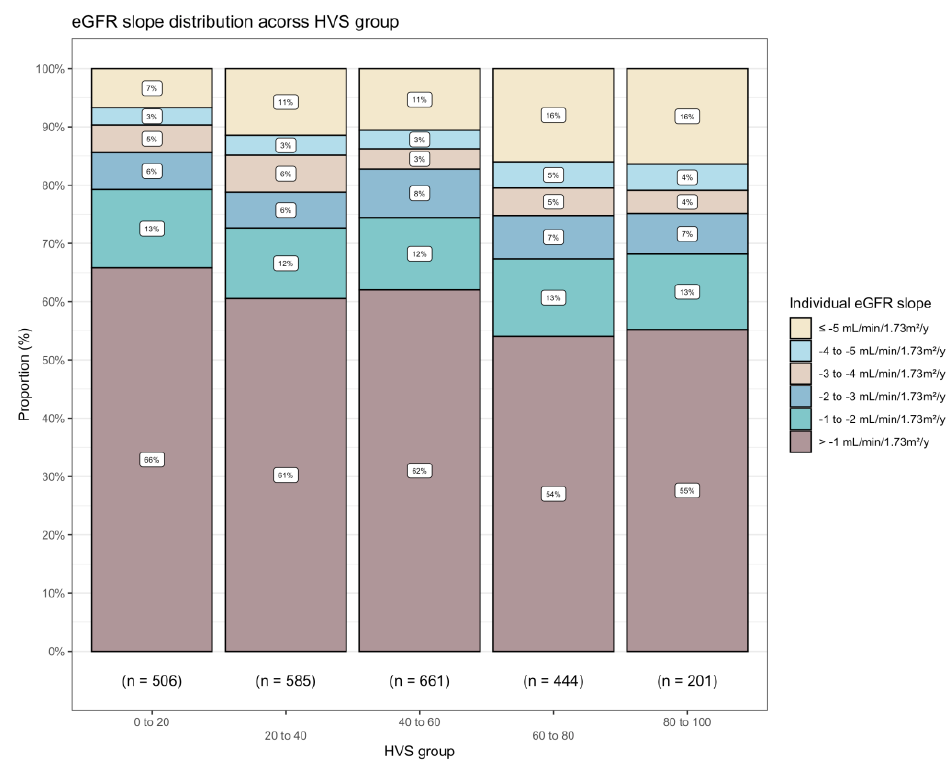
Figure 1. Descriptive analysis for distribution of mean eGFR slope during the whole follow-up in each HVS category. Abbreviations: HVS, glycated haemoglobin A1c variability score; eGFR, estimated glomerular filtration rate. Mean eGFR slope is individual mean eGFR annual change starting from baseline to end of follow-up. The unit of HVS is %.